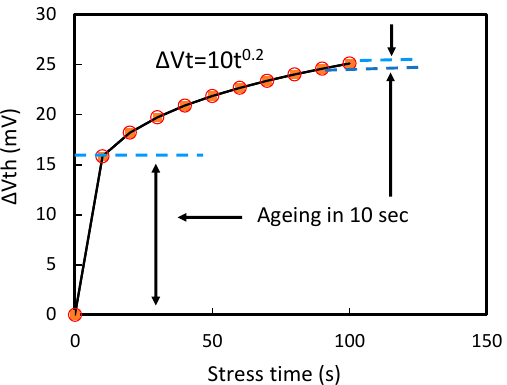
Figure 12. An illustration of the rapid reduction in the aging rate with stress time.